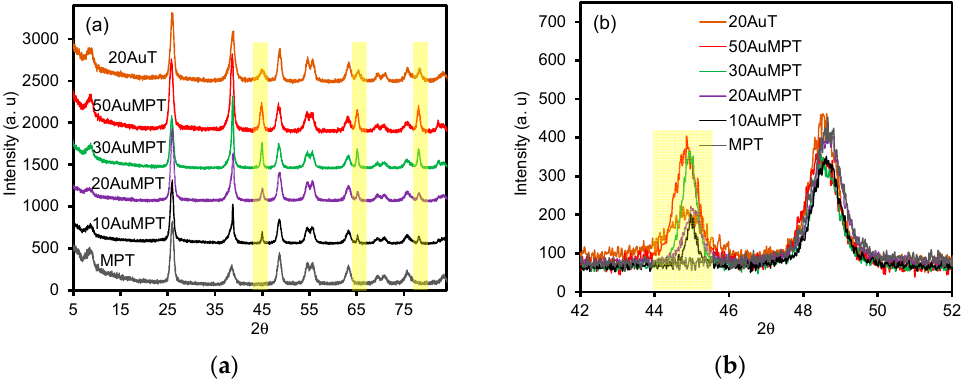
Figure 5. PXRD patterns of bare MPT (mesoporous TiO 2 and various AuNP-loaded MPT composite particles: ( a ) offset scale spectra for clear presentation; ( b ) overlayed and expanded spectra to compare peak widths (highlights in yellow indicate peaks from AuNPs). (Note: AuT, AuNPs onto nonporous TiO 2